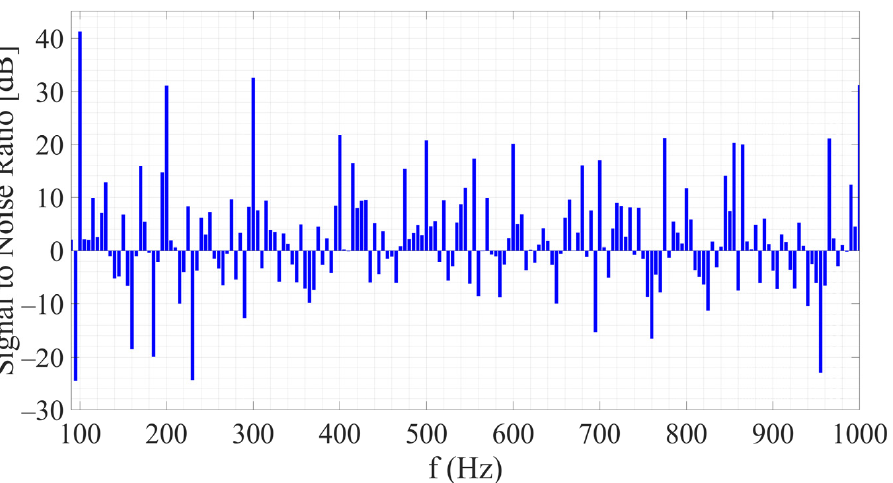
Figure 3. Single-sided amplitude spectrum of Signal to Noise Ratio for point 75 at the surface 5 of the transformer.